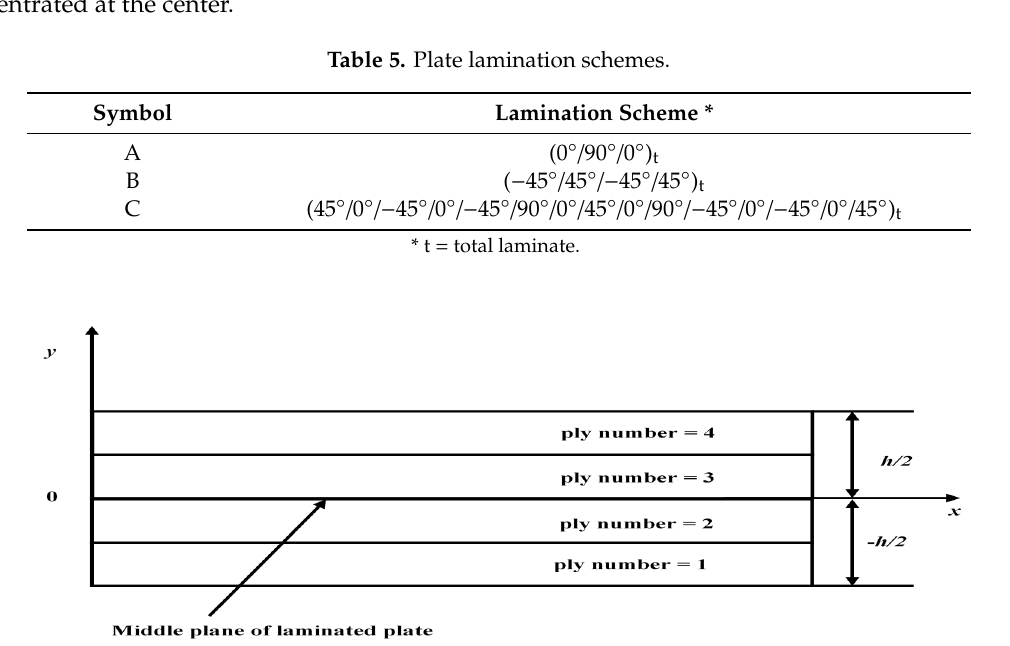
Figure 3. Typical front view of a four-layer laminated plate with ply numbering. Table 5. Plate lamination schemes.